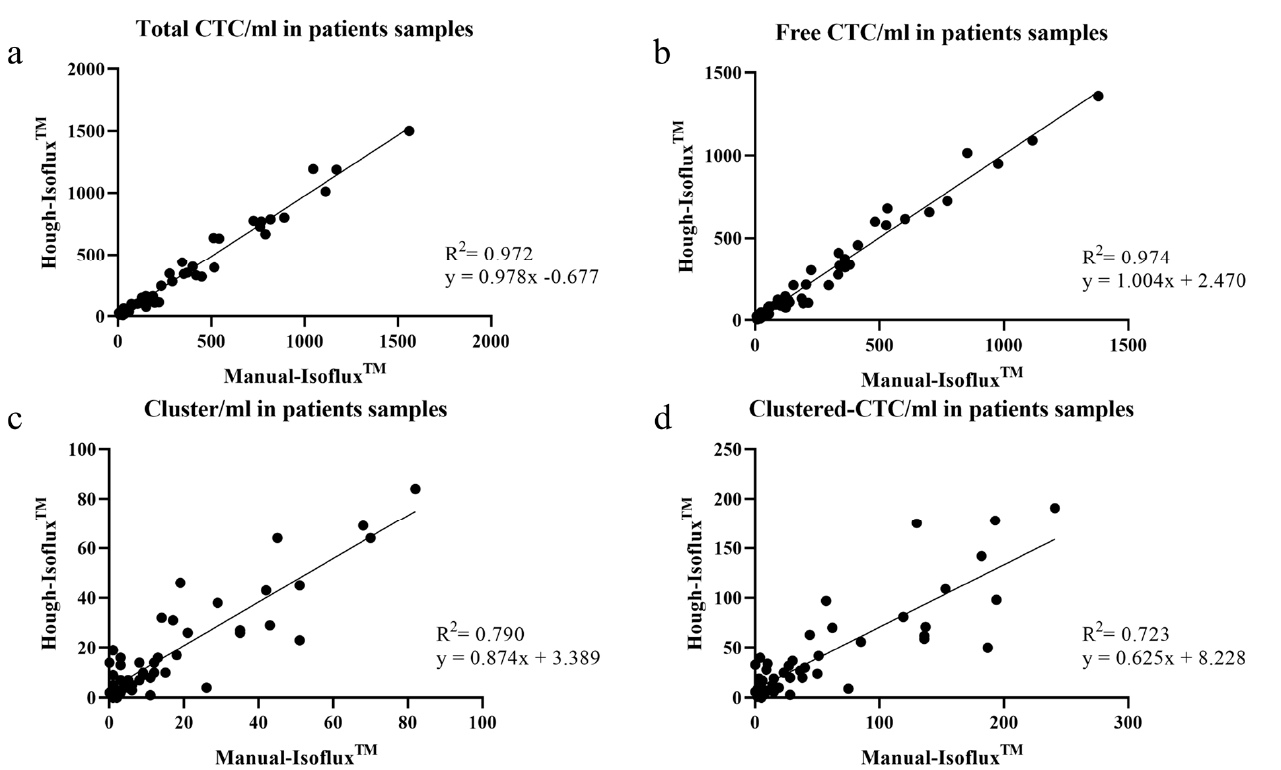
Figure 4. Correlation plot of CTC/mL in pancreatic cancer patient samples counted with the Manual- Isoflux TM System and with the Hough-Isoflux TM System. ( a ). Total-CTC correlation. ( b ). Free-CTC correlation. ( c ). Cluster correlation. ( d ). Clustered-CTC correlation.